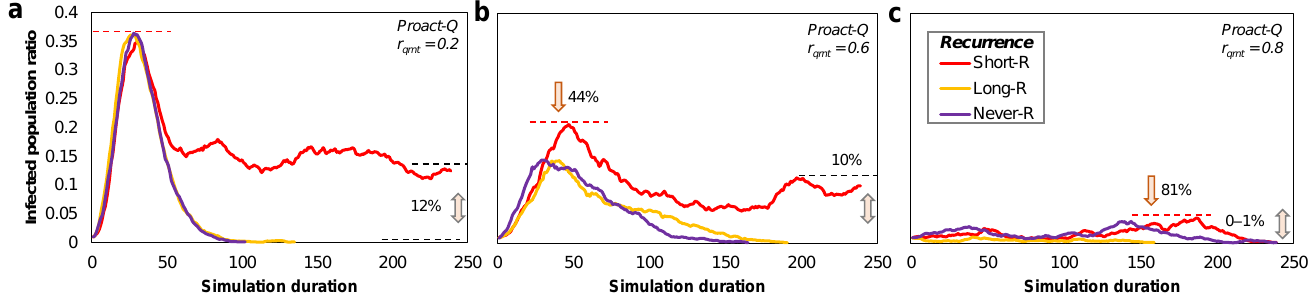
Figure 7. Evolution of epidemic outbreaks in time by employing a proactive quarantine policy (proact-Q) from the perspective of the three recurrence scenarios, using different quarantine ratios in each of the three panels. ( a ) A “less restrictive” quarantine ( r qrnt = 0.2) which triggers the highest infection peaks ( ψ = 0.36) for all recurrence scenarios. The short-R scenario leaves a residual (ongoing) infection of 12% at the end of the simulation. ( b ) A “moderately restrictive” quarantine ( r qrnt = 0.6) which lowers the infection peaks ( ψ = 0.20 for short-R, in red) for all recurrence scenarios. Again, the short-R scenario leaves a residual infection of around 10%. ( c ) A “highly restrictive” quarantine ( r qrnt = 0.8) which lowers the infection peaks even further ( ψ = 0.002–0.038) for all recurrence scenarios. Almost no residual infection remains in the population. The decreases in the peak infection ratio for short-R (red) are displayed for the quarantine ratios r qrnt = 0.6,0.8 relative to the highest peak measured for r qrnt =